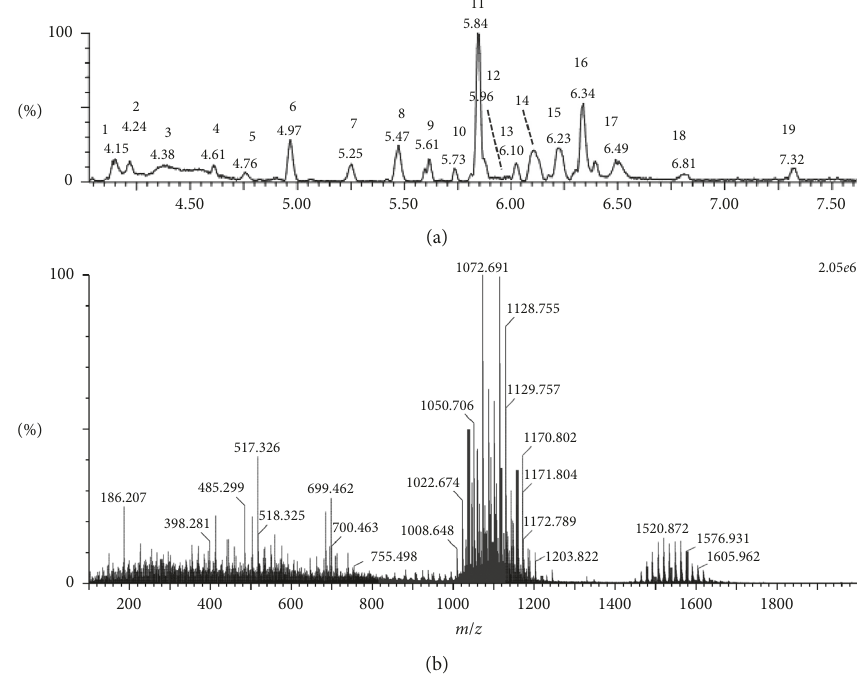
Figure 1: Total ion chromatogram (TIC) in the positive ion mode (a). The mass ion extracted from TIC with retention time 4.15–7.32min